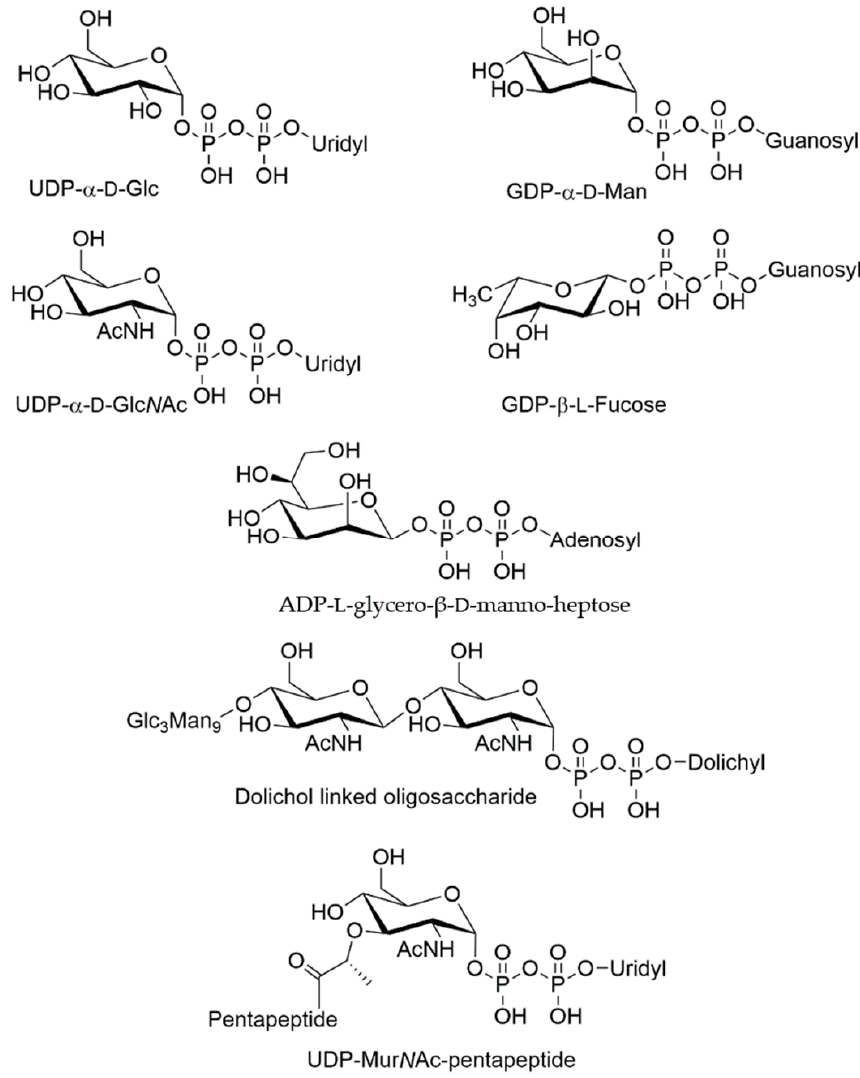
Figure 1. Biologically relevant glycosyl diphosphates .